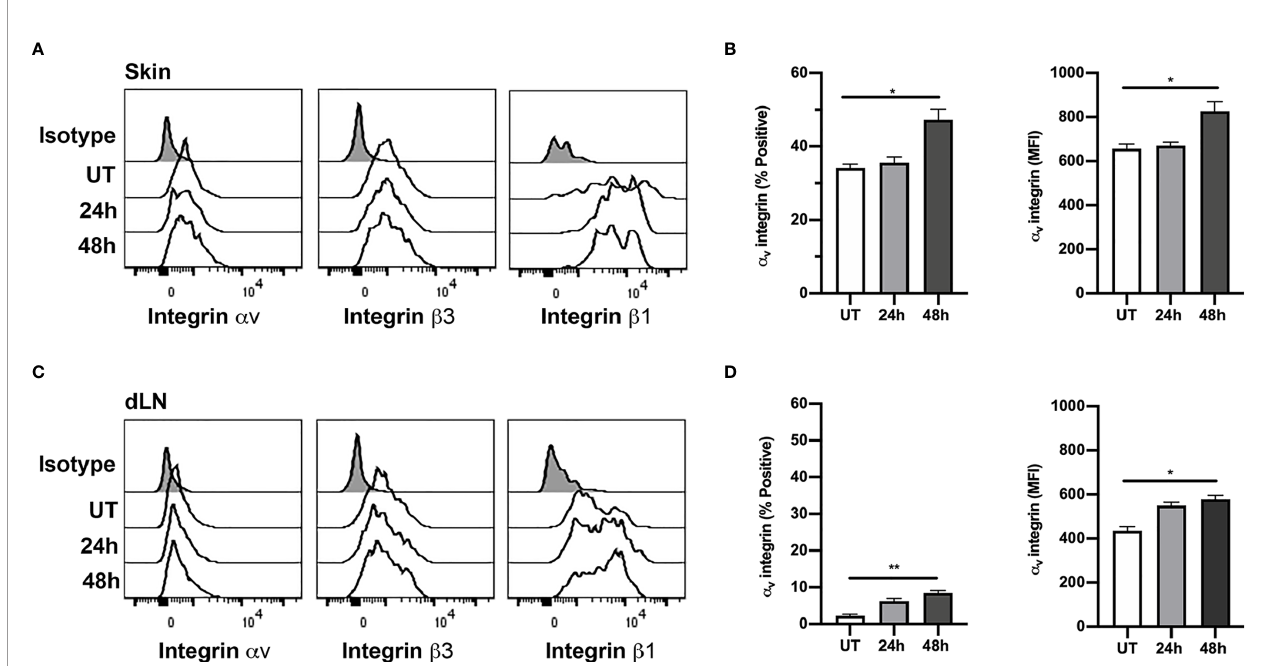
FIGURE 6 | Expression of a v , b 1 and b 3 integrins on Tregs in skin and dLN. a v , b 1 and b 3 integrin expression on Tregs from skin and draining lymph nodes (dLN) of untreated (UT) mice, and 24 and 48 h post CS induction was assessed using fl ow cytometry. (A, C) Example histograms of Tregs from skin (A) and dLN (C) comparing expression of a v , b 1 and b 3 integrins. Data also shown for isotype control (shaded histograms). (B, D) ⍺ v integrin expression on Tregs from skin (B) and dLN (D) , shown as % positive and mean fl uorescence intensity (MFI) on cells from untreated (UT) mice, and 24 and 48 h post CS induction. Data are shown as mean ± SEM derived from 4 mice/group. Data were evaluated via Kruskal-Wallis test with Dunn ’ s multiple comparison tests between all timepoints. * p < 0.05, ** p < 0.01 for the comparisons